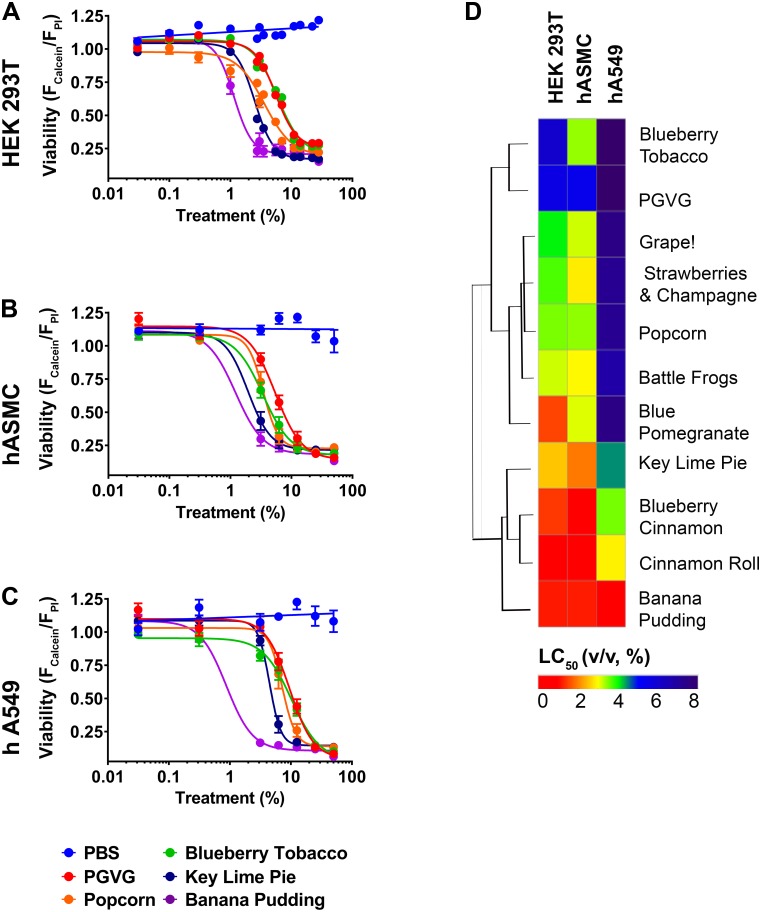
Orthogonal assays to validate human airway cell types.(A–C) Representative dose–response curves assayed in HEK293T. (A) hASMC; (B) hA549; (C) PBS (negative control), PG/VG (positive control); Blueberry Tobacco, Popcorn, Key Lime Pie, and Banana Pudding show left-shifted but similar toxicity trends. All n = 3. (D) Heat map showing all e-liquid flavors tested in the 3 cell lines above. E-liquids have been clustered by LC50 values. Raw data are available in S4 Data. hA549, human adenocarcinomic alveolar basal epithelial cells; hASMC, human airway smooth muscle cell; HEK293T, human embryonic kidney 293 cells; LC50, concentration at which a given agent is lethal to 50% of the cells; PBS, phosphate-buffered saline; PG, propylene glycol; VG, vegetable glycerin.